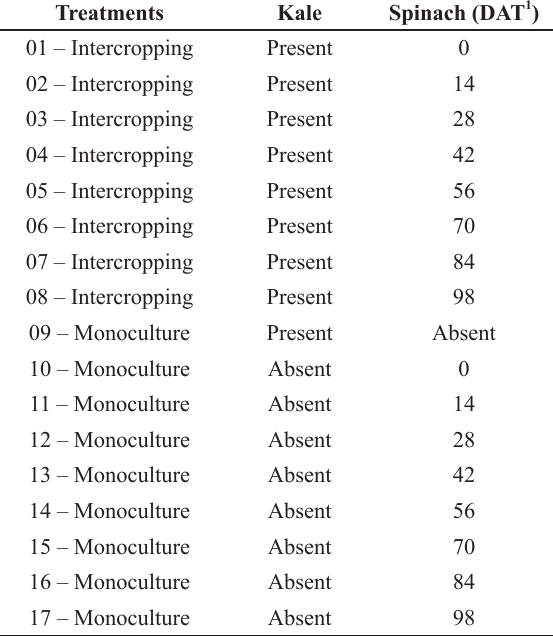
Characterization of treatments of ‘New Zealand’ spinach and kale in monoculture and intercropping